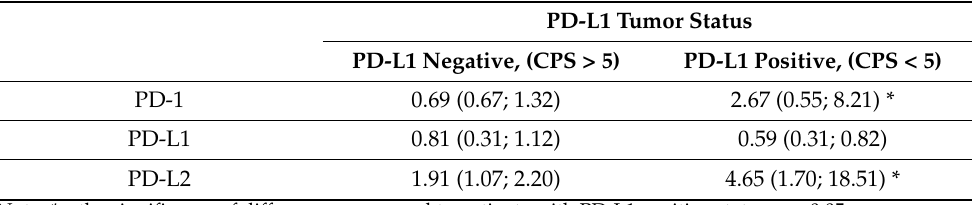
Table 1. PD, PD-L1, PD-L2 expression in GC tissues depending on IHC PD-L1 status, Me (Q1; Q3).